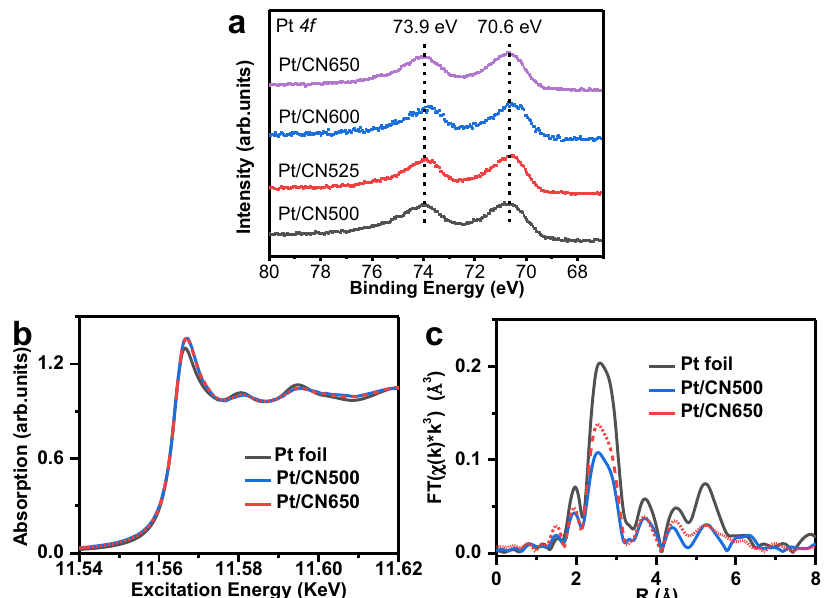
Fig. 3 Chemical states of Pt nanoparticles over different carbon nitride supports. a Pt 4 f XPS spectra. b , c X-ray absorption spectra. b X-ray absorption near edge structure (XANES) region. c The k 3 -weighted FT-EXAFS